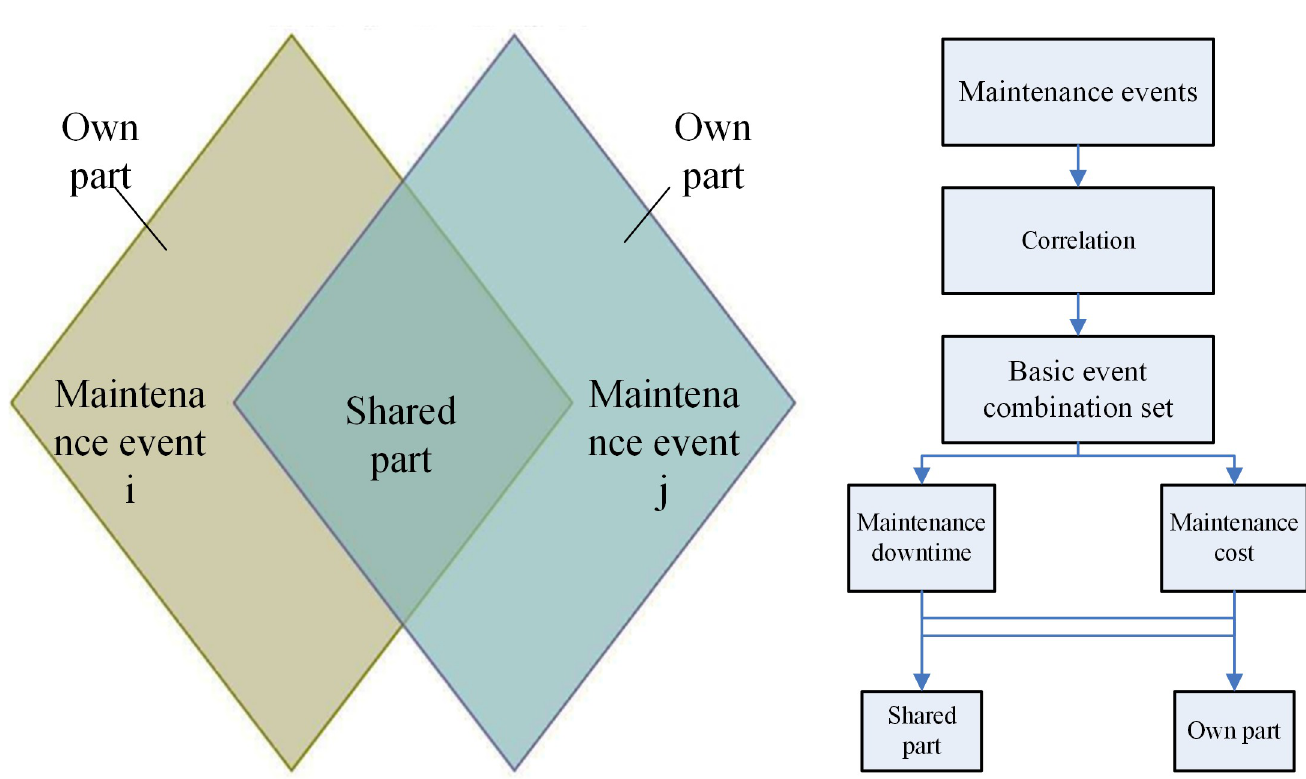
Fig 5. Own part and shared part